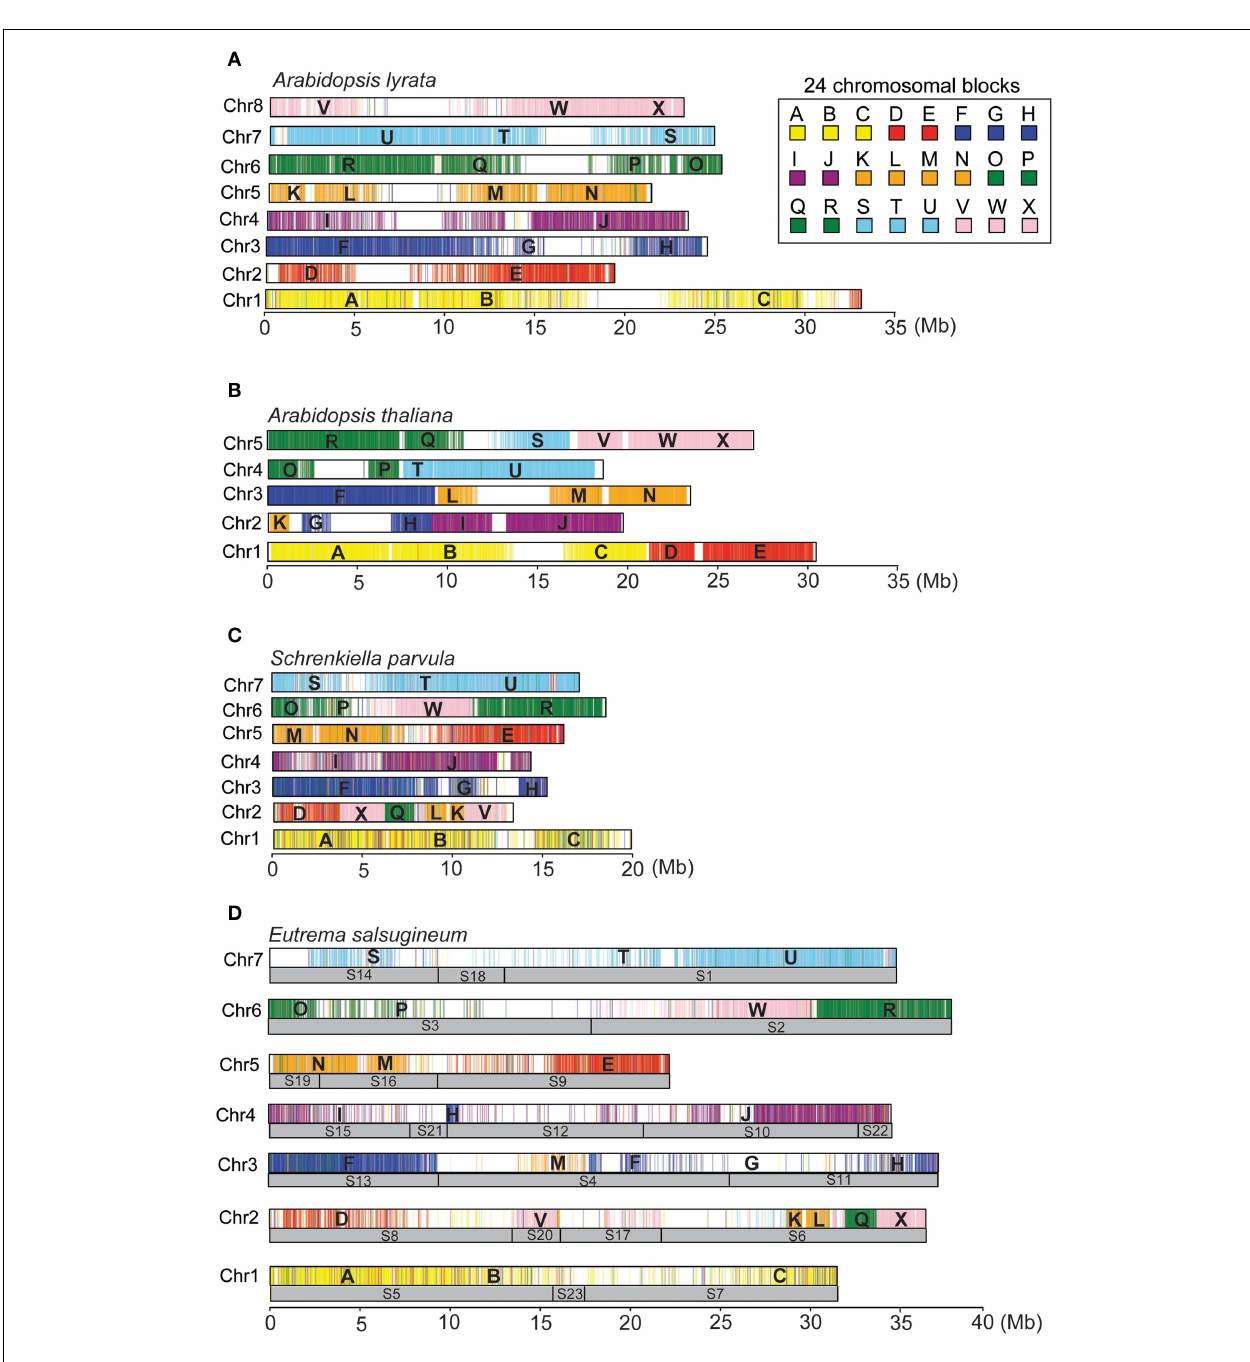
function of certain subfamilies of F-box genes is to recognize specific substrates in ubiquitin-dependent protein